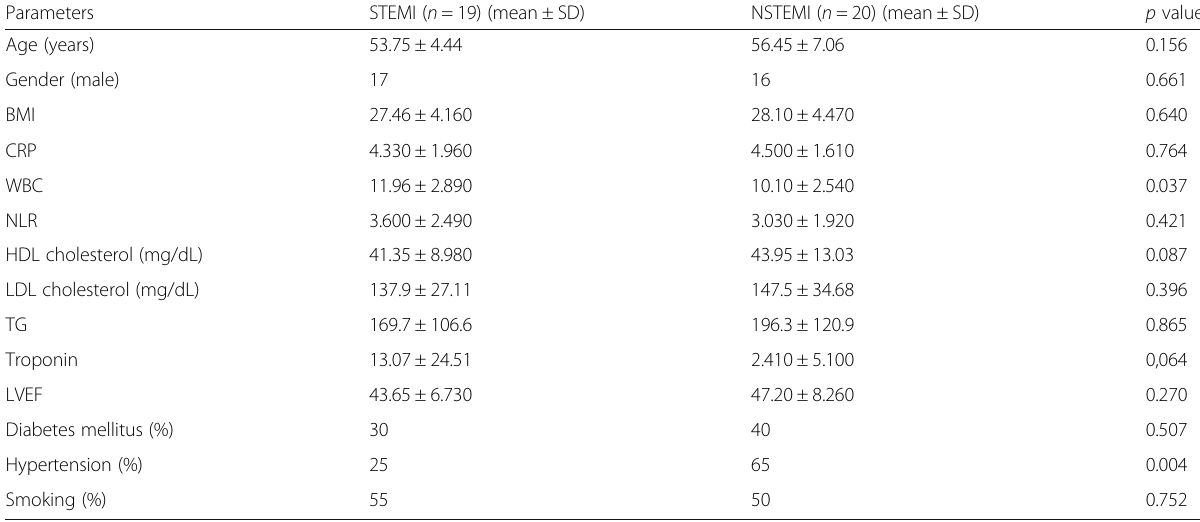
Table 1 Demographic features and laboratory parameters of patients who suffered from STEMI and NSTEMI